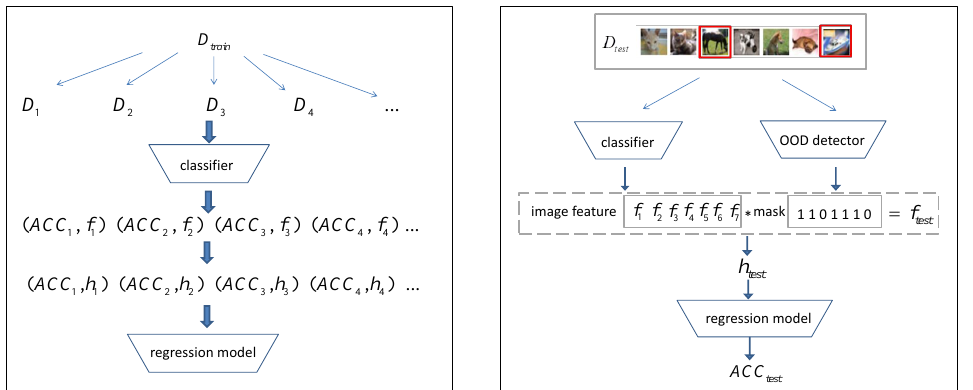
Figure 1. Left : The training process of the regression model. We first generate a set of transformed datasets from the training set and use the information from transformed datasets to train the regres- sion model for predicting model accuracy. Note that in these transformed datasets, the mask of the images is always set to 1 because the labels of these images have not changed and still belong to the original distribution. Right : We use the trained regression model to predict the accuracy of the model, and the image shown in the red box indicates out-of-distribution (OOD) data. To avoid the impact of these OOD images on the prediction of the regression model, an OOD detector sets the mask of the corresponding features of the image to